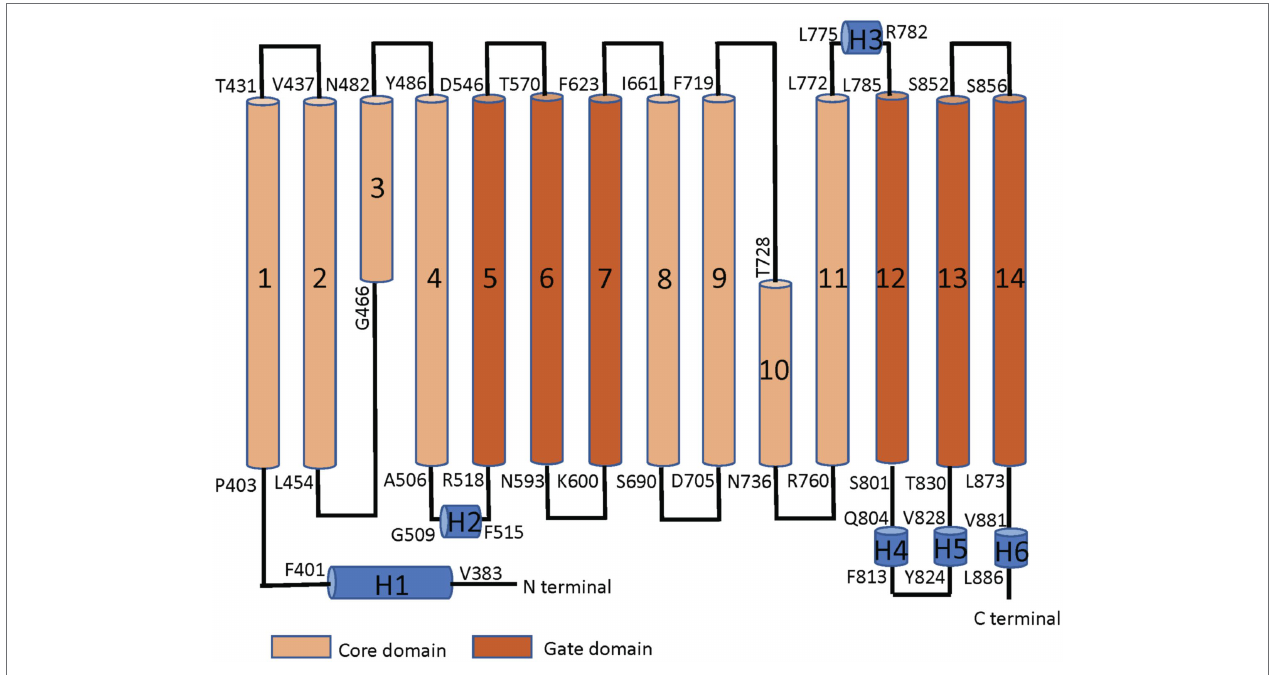
FIGURE 3 | Linear topology of the membrane domain of human Band 3 showing its 14 TM structure with both the N − and C-termini on the cytoplasmic side of the membrane. The residues at the start and the end of the TM helices are shown. The TM segments in the core domain are shown in light brown and the segments in the gate domain in dark brown. TM3 and 10 are short helices that bind the substrate anion at their amino-terminal ends in the middle of the protein. Short helical regions joining TM segments are shown in blue (Adapted from Reithmeier et al.,